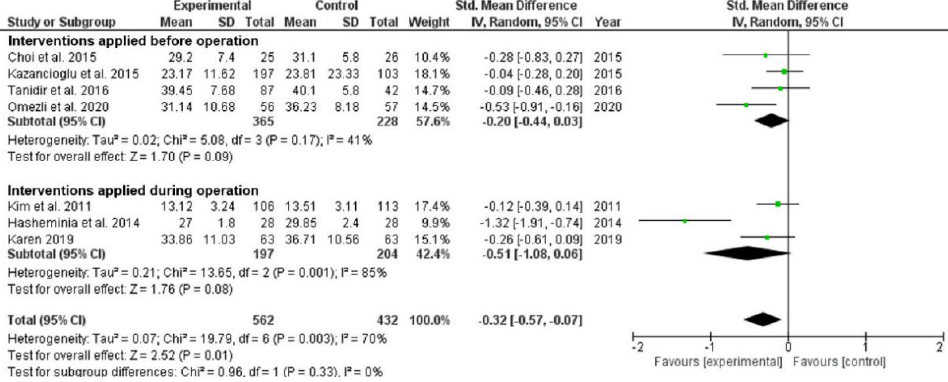
Figure 4. Forest plot of comparison: sub-group analyses—changes in anxiety level between groups with non-pharmacological interventions applied before and during third molar extraction [15,35,37,38,40,43,46].